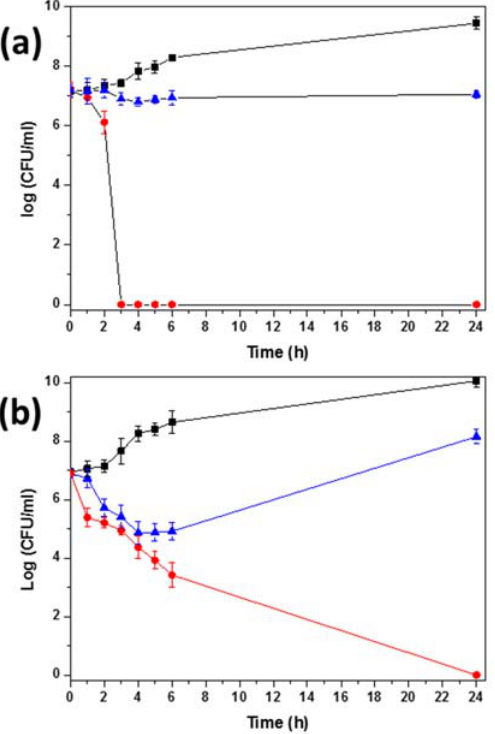
Figure 6. Time–kill curves of ( a ) P. aeruginosa (PFQ2), ( b ) E. coli (ATCC25922), and control (black squares) in presence of GO-Ag (blue triangles) and GOCOOH-Ag (red circles) at 12.66 µg/mL. The data were presented as means and SD of at least three independent experiments.